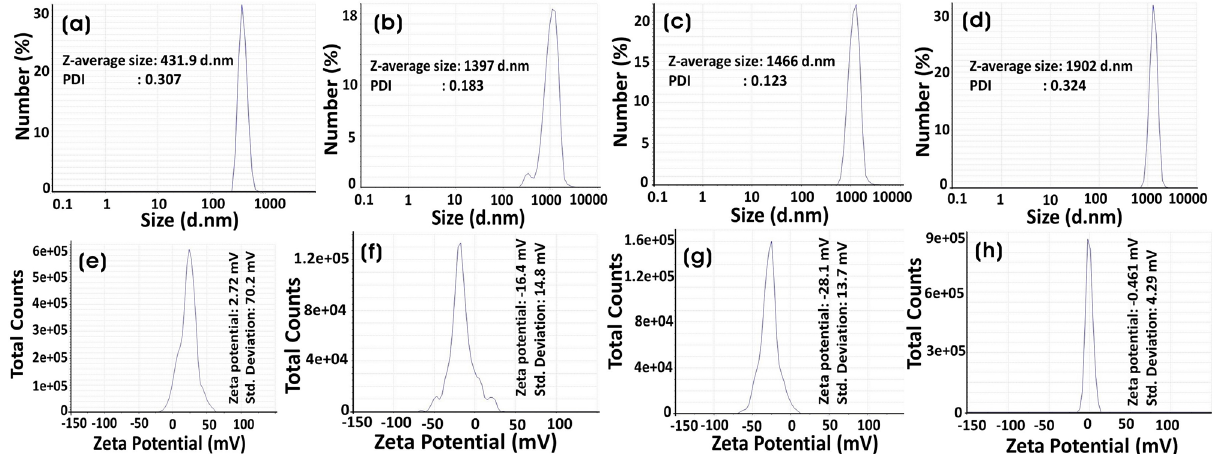
Figure 3. ( a – d ) Dynamic light scattering of particle size distribution and ( e – h ) zeta potentials of ZnO, Ag 0.2 @ ZnO, Ag 0.4 @ZnO, and Ag 0.8 @ZnO